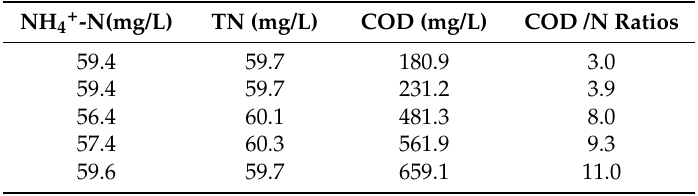
Table 1. The influent concentrations of pollutants under different COD/N